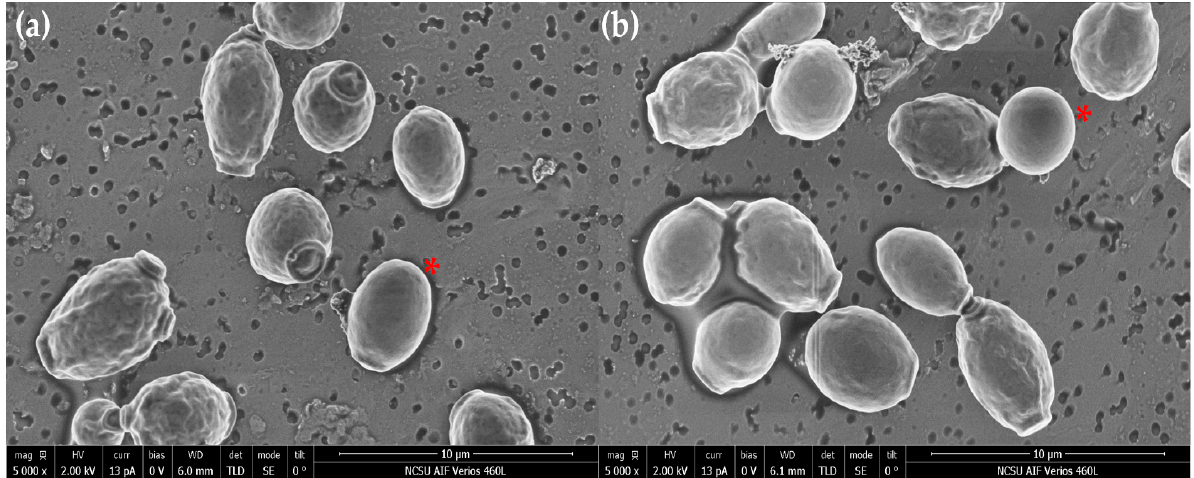
Figure 5. SEM micrographs of NS commercial ( a ) and NS naïve ( b ) yeast exposed to the MIC. The red asterisks indicate cells that do not have a drastic physical change and resemble controls.